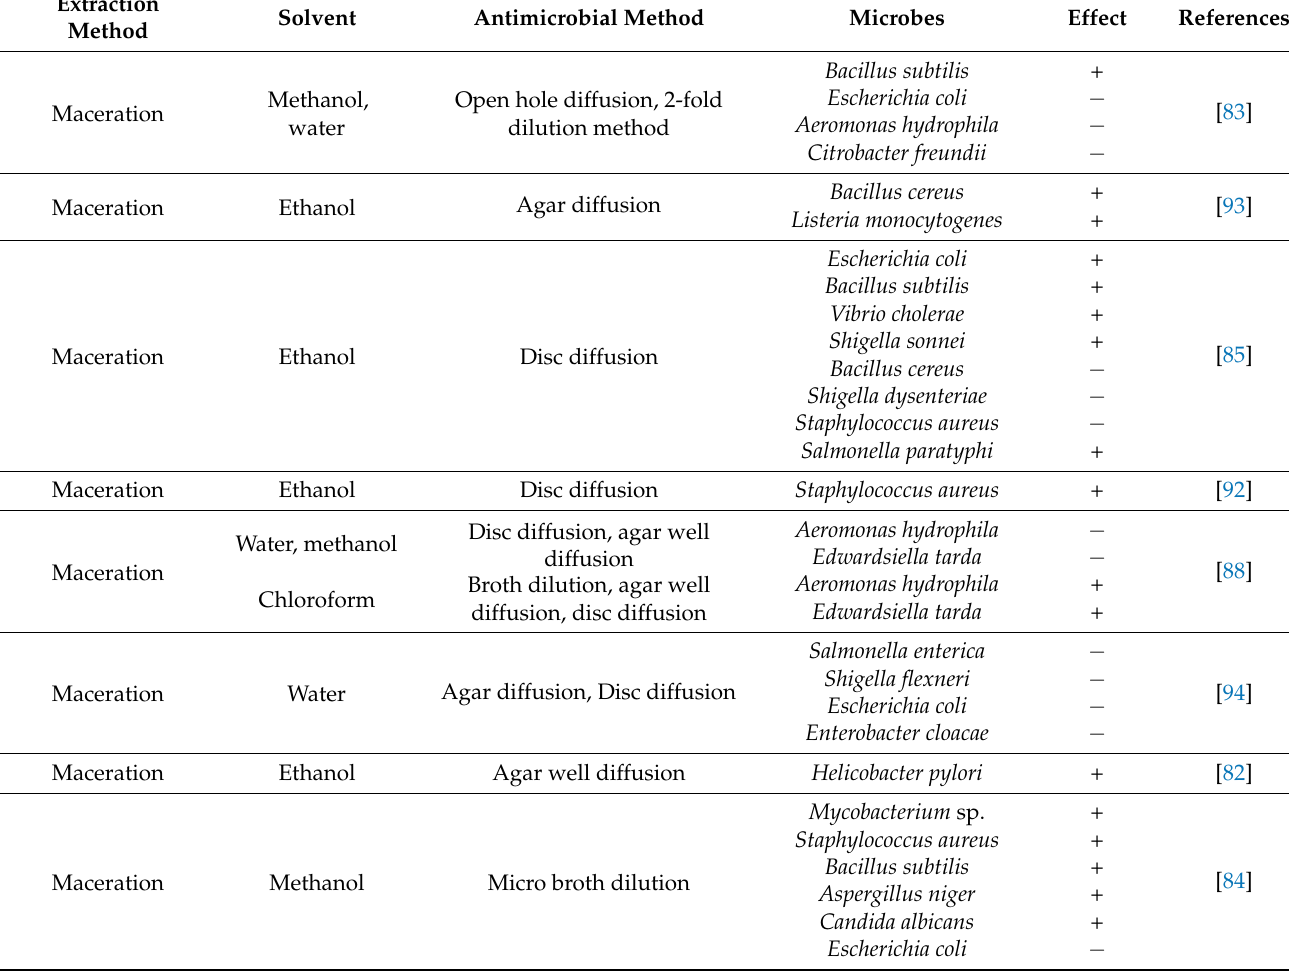
Table 2. Antimicrobial activity of C. asiatica extracts obtained by various methods.